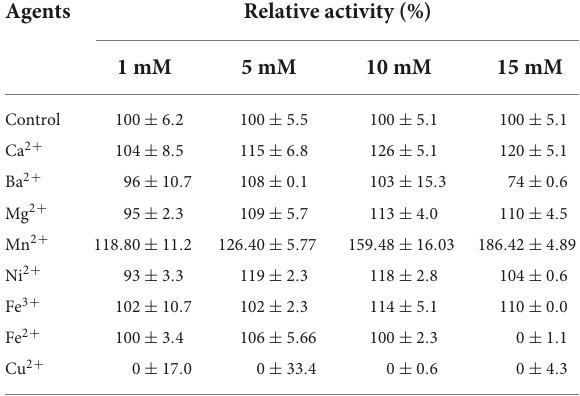
TABLE 3 Effect of metal ions on the activity of prot DS5.